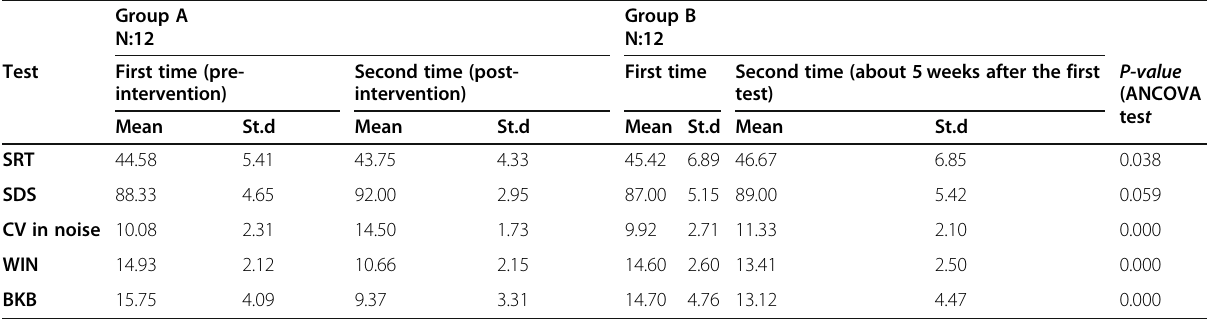
Table 4 Mean and standard deviation of SRT in quiet, SDS in quiet, CV in noise, WIN, and BKB in groups A and B. The ANCOVA was used to compare the second time results between two groups: A, intervention group, and B, control group Group A N:12